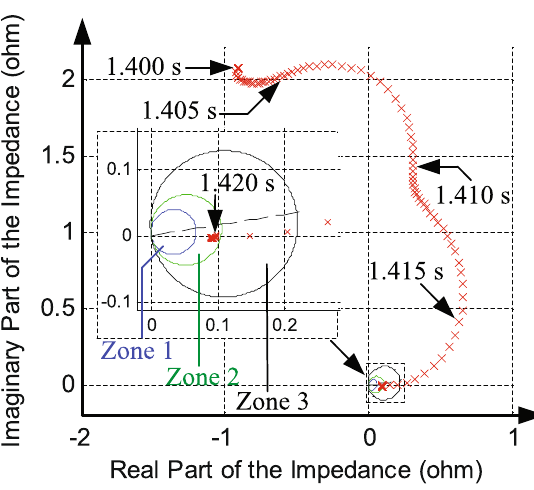
Fig. 17 Three phase currents and voltages of event 4: